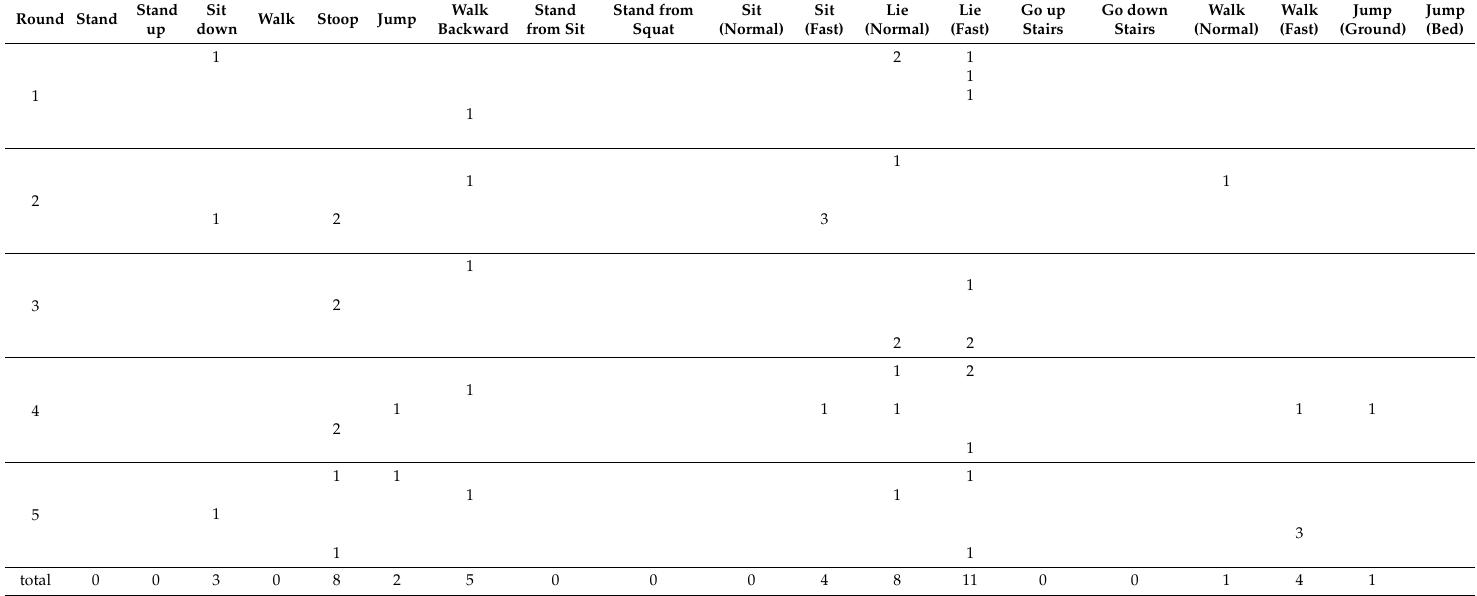
Table A3. The total testing data of false predictions for falls and ADLs using the machine learning–based algorithm. Round Stand Stand